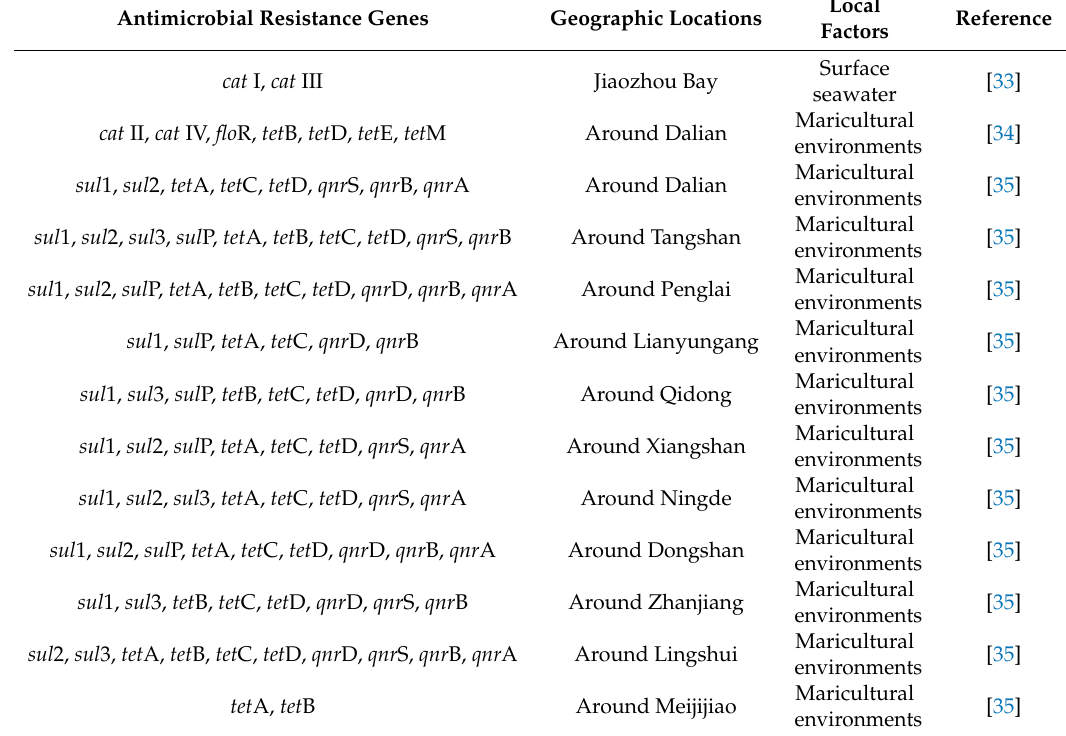
Table 2. Information of antimicrobial resistance genes detected in marine environment of China. Antimicrobial Resistance